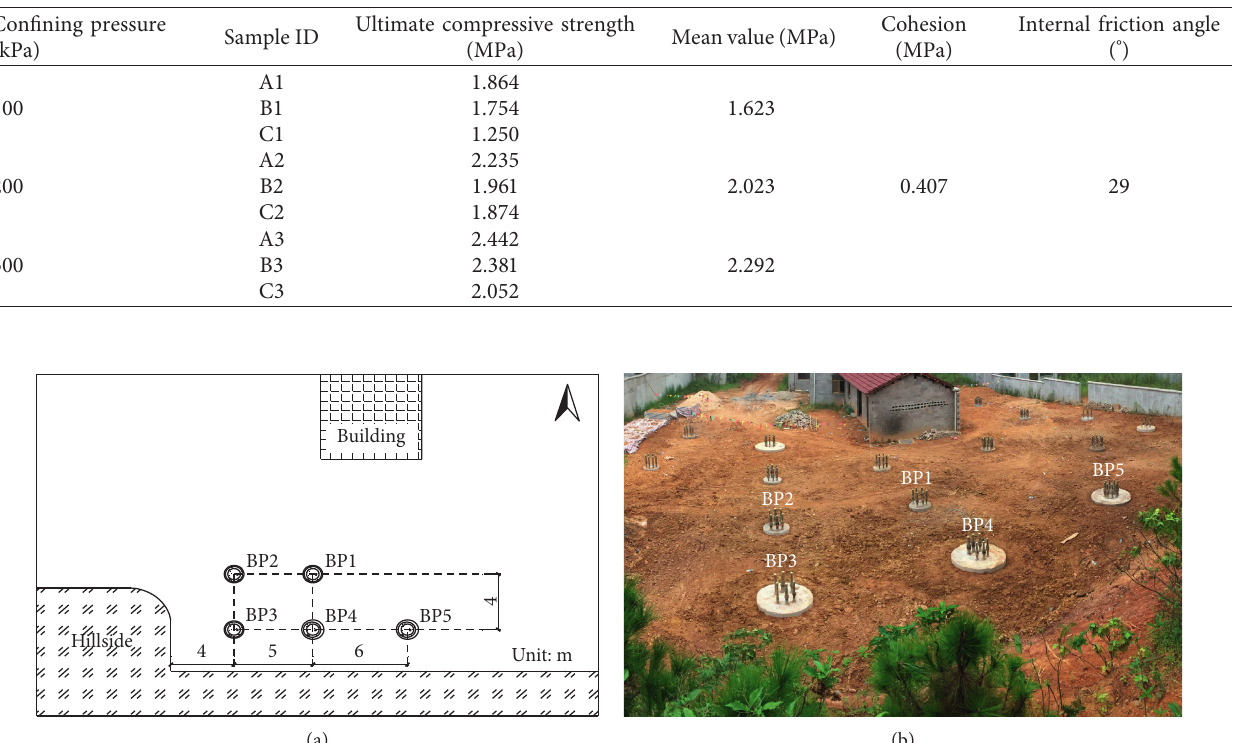
Figure 1: In situ direct shear testing: (a) pit exploration illustration; (b) shearing test in progress. Table 2: The results of triaxial compression tests on the rock samples in natural state.